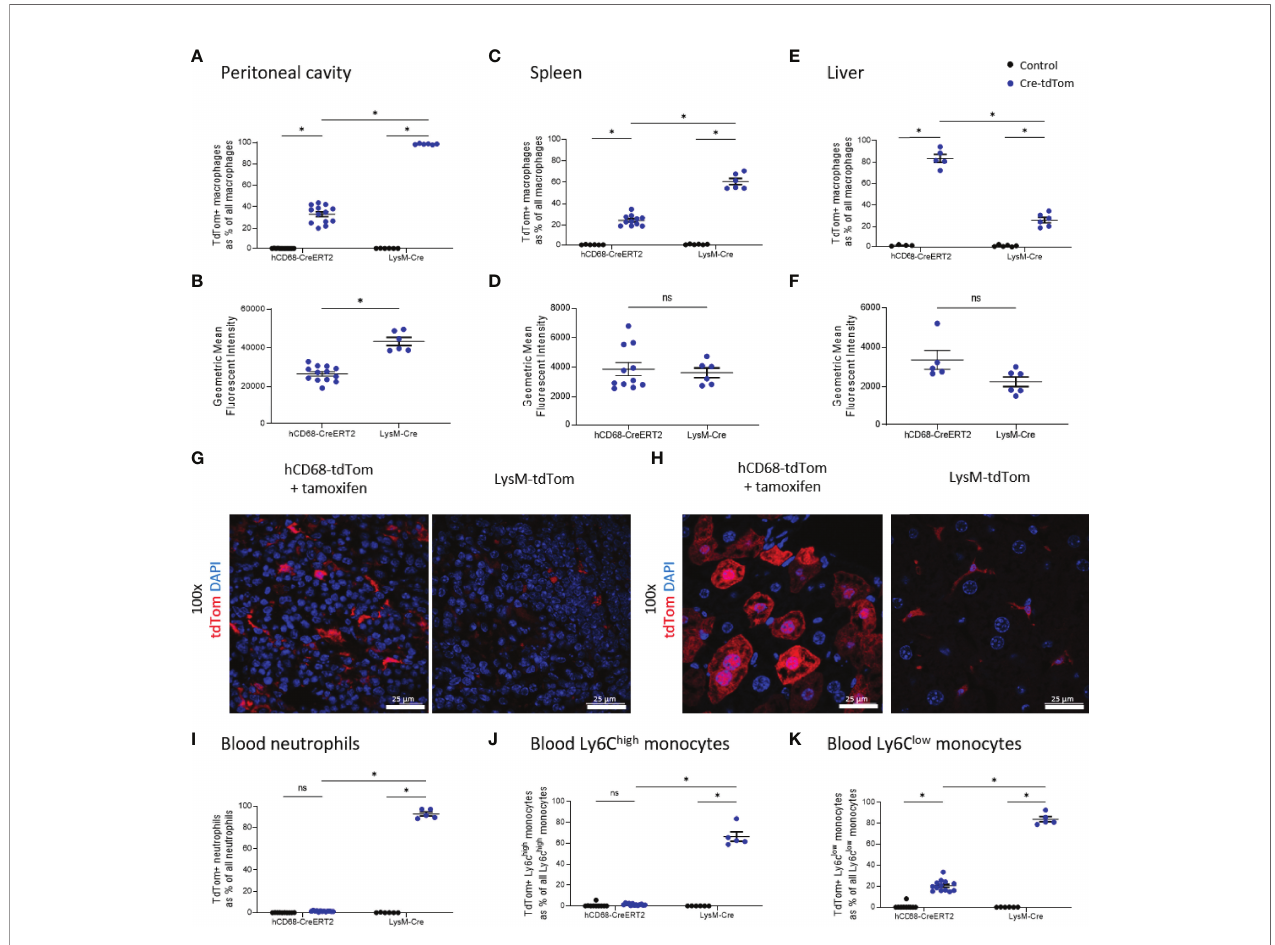
FIGURE 6 | The hCD68 promoter driven inducible Cre recombinase improves targeting of liver macrophages compared to LysM-Cre. In all panels control mice (littermates of hCD68-tdTom mice that were given tamoxifen or littermates of LysM-tdTom mice) are marked as black dots; Cre-tdTom mice (hCD68-tdTom + tamoxifen or LysM-tdTom mice) are marked as blue dots. Frequency of tdTomato-expressing macrophages as a proportion of all macrophages in (A) peritoneal cavity (C) spleen and (E) liver with corresponding mean fl uorescence intensity of tdTomato + macrophages for hCD68-CreERT2 and LysM-Cre mice in (B, D, F) . Representative immuno fl uorescence images of endogenous tdTomato expression in (G) the spleen and (H) the liver of hCD68-tdTom and LysM-tdTom mice at 100x magni fi cation with DAPI in blue and tdTomato in red; scale bar = 25 µm. Frequency of tdTomato-expressing blood (I) neutrophils, (J) Ly6C high monocytes and (K) Ly6C low monocytes as a proportion of all blood leukocytes of the given type for hCD68-CreERT2 and LysM-Cre mice.; two-way ANOVA in panels (A, C, E, I – K) , student t-test in panels (B, D, F) , (* = p < 0.05). ns, not signi fi